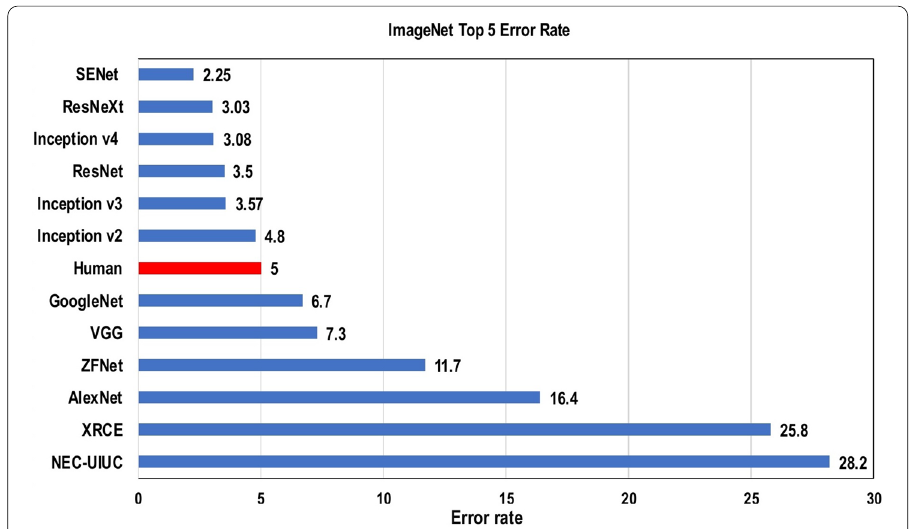
Fig. 4 Deep learning performance compared to